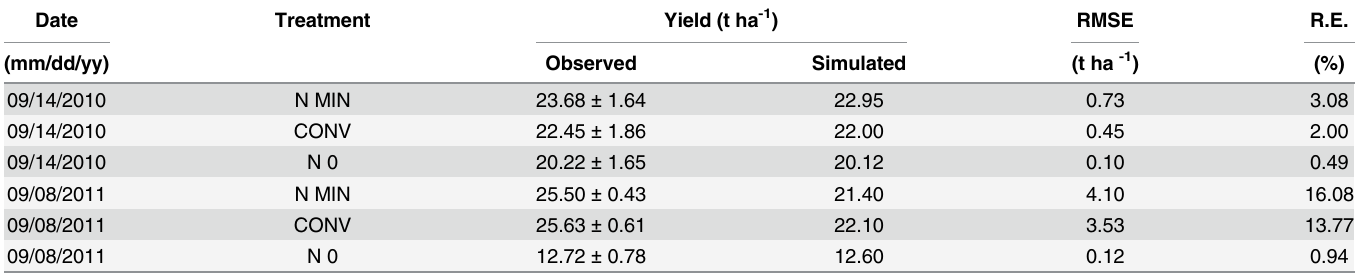
Table 8. Observed (means and standard errors, n = 3) and simulated silage maize yields for the NMIN, CONV and N0 treatments. Yields are only reported for maize as triticale was harvested for silage. Sampling dates correspond to the harvest of maize. Date Treatment Yield (t ha -1 ) RMSE R.E.